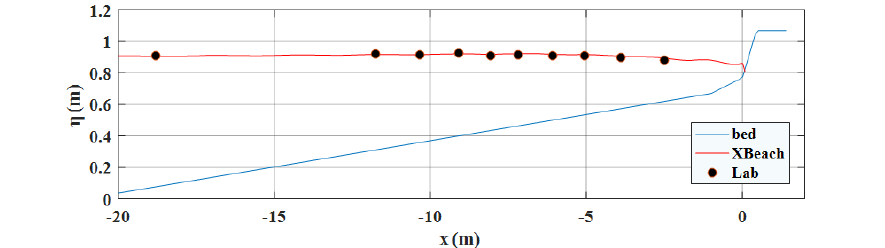
Figure 5. Free-surface profile of a random wave generated with JONSWAP spectrum propagating on a composite beach. Symbol: laboratory data by Løvås and Tørum [27]. Line: numerical results by XBeach [20]. In this case, the peak frequency of the incident wave is 2.5 s, the significant wave height is 0.14 m, and the constant depth is 0.77 m. The part of the composite beach shown here has a slope of 1:30, 1:10, and 1:1.5 (from left to